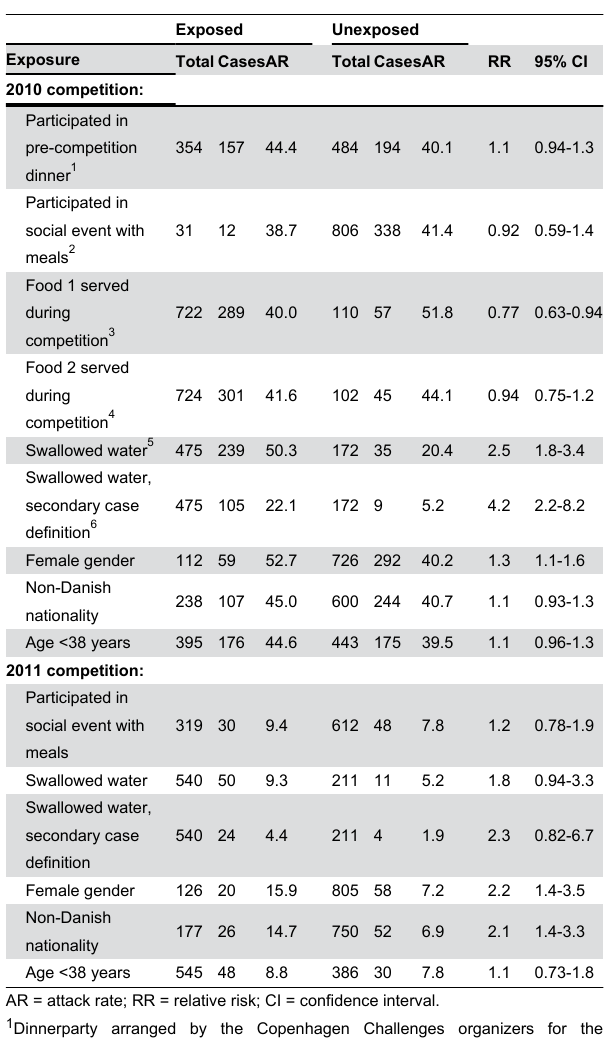
Table 2. Exposure specific attack rates, relative risks and 95% confidence intervals, Triathlon competitions, Copenhagen, 2010 and